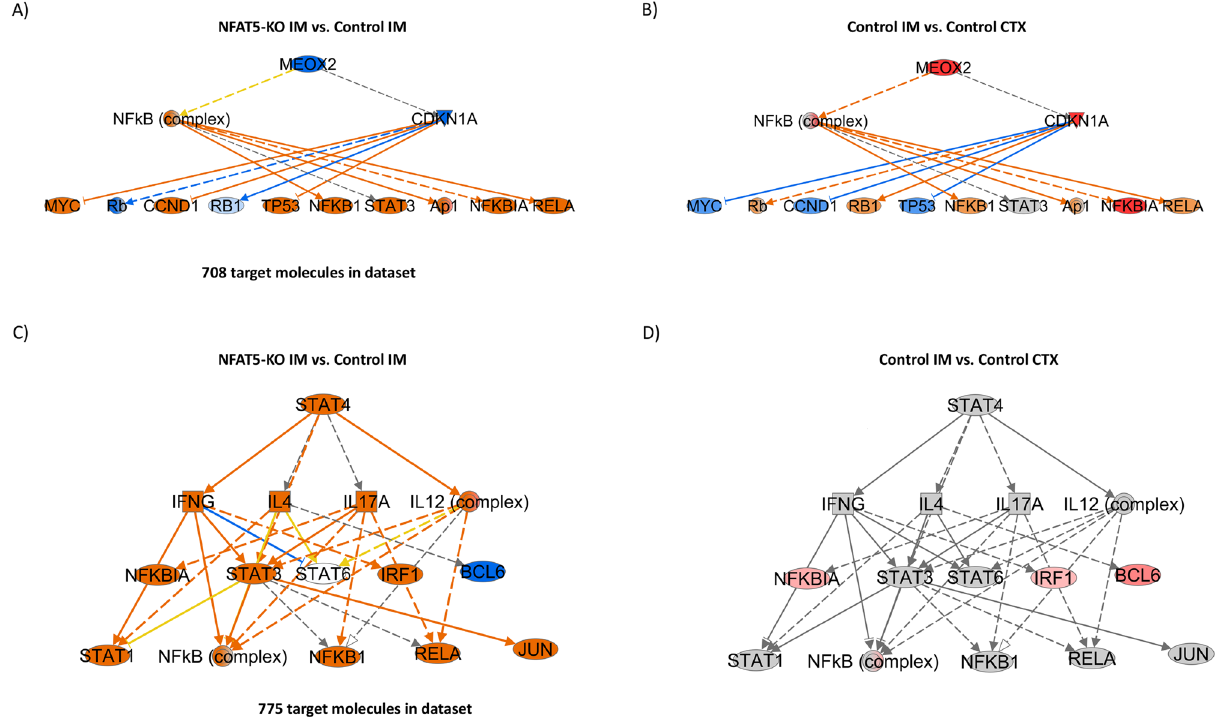
Figure 8. Loss of NFAT5 in IM is predicted to inhibit MEOX2 and activation of a STAT4 mechanistic network. Functional analysis using Ingenuity’s pathway analysis (IPA) predicted activation of MEOX2 and associated molecules. ( A ) MEOX2 and associated network predicted to be affected based on the gene expression pattern in NFAT5-KO IM compared to control IM. ( B ) Network and the predicted activation state based on the gene expression pattern obtained in control IM vs CTX comparison. ( C , D ) The predicted activation of STAT4 mechanistic network based on changes in gene expression in NFAT5-KO IM vs control and control IM vs CTX, respectively. The colors indicate predicted activation state. Orange lines/shapes = predicted activation/activated; blue lines/shapes = predicted